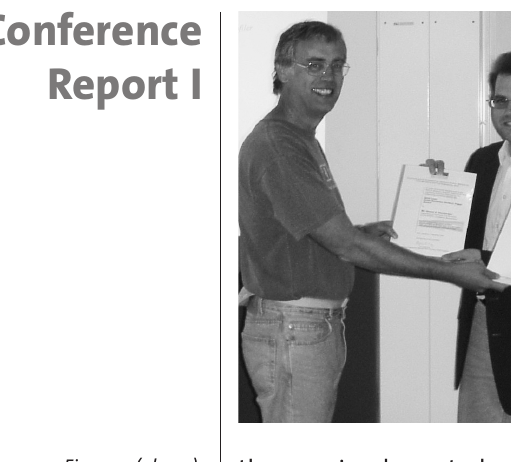
Figure 2 (above): Student Paper Award Ceremony (Price-giving by Greg King, Chairman of the competition, to Daniel S. Hersberger (left) and Adhy Kurniawan (right)).